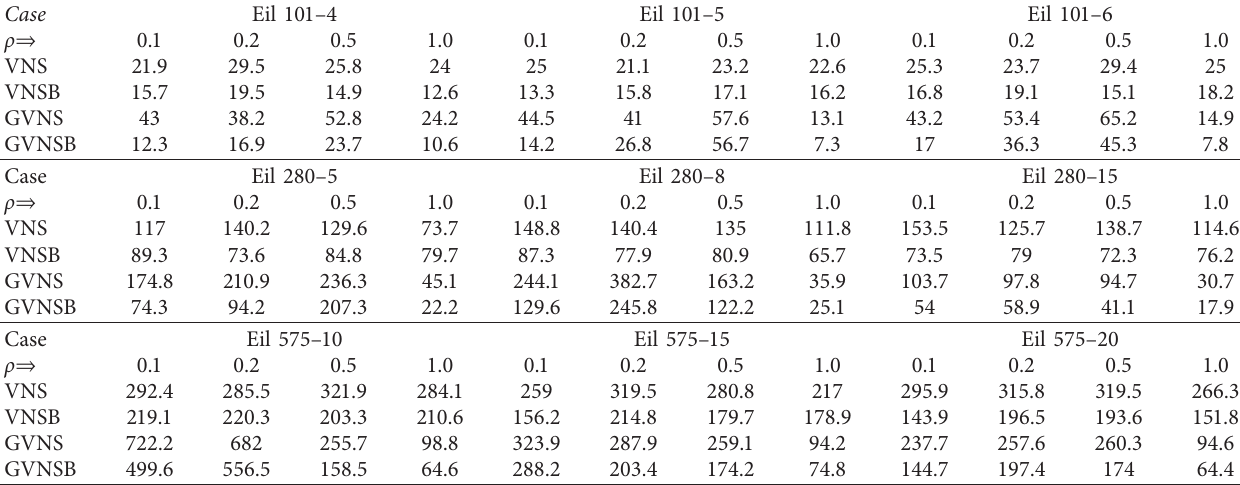
Table 4: Standard deviations of VNS, VNSB, GVNS, and GVNSB in environment τ �